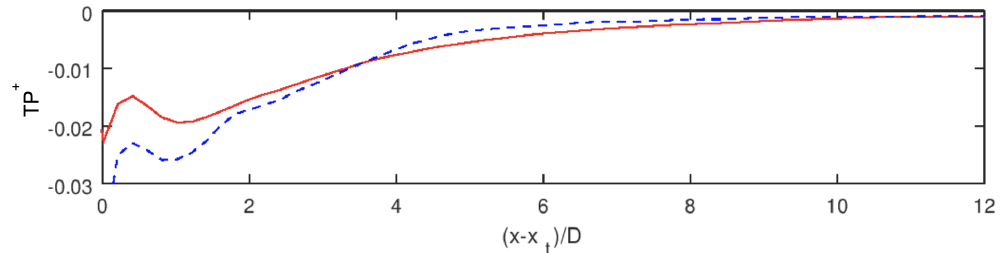
Figure 14. The turbulence production (TP) term (Equation (10)). Red line: T80; Blue line: T27. The TP DU 3 term is normalized using 1 2 h